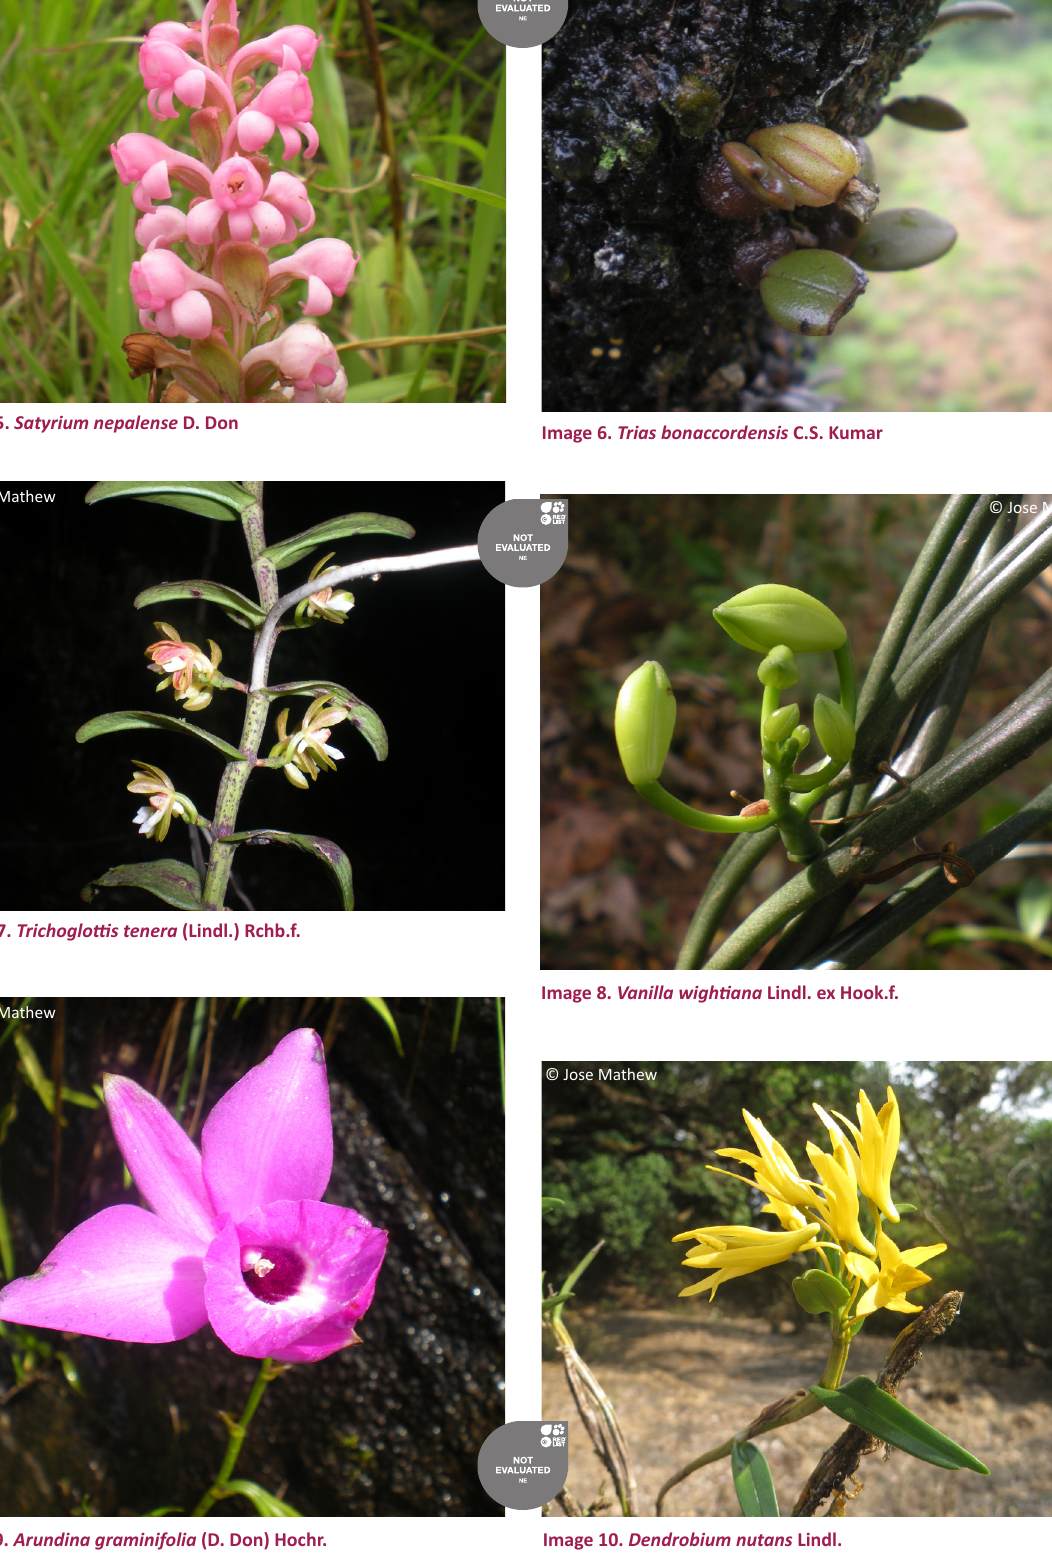
Image 9. Arundina graminifolia (D. Don) Hochr. Image 10. Dendrobium nutans